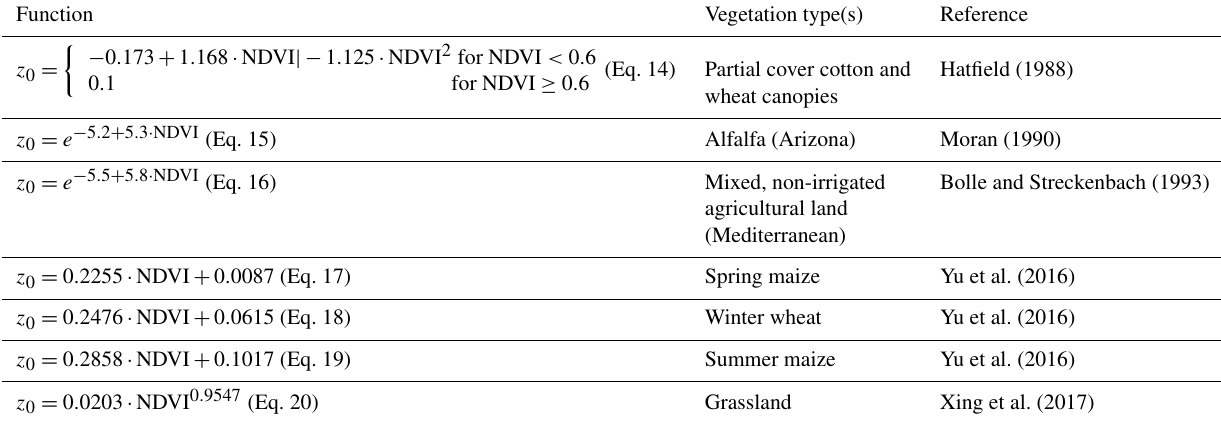
Table 3. Studies that relate the aerodynamic roughness length ( z 0 ) to satellite-derived NDVI values for specific land cover types and condi-